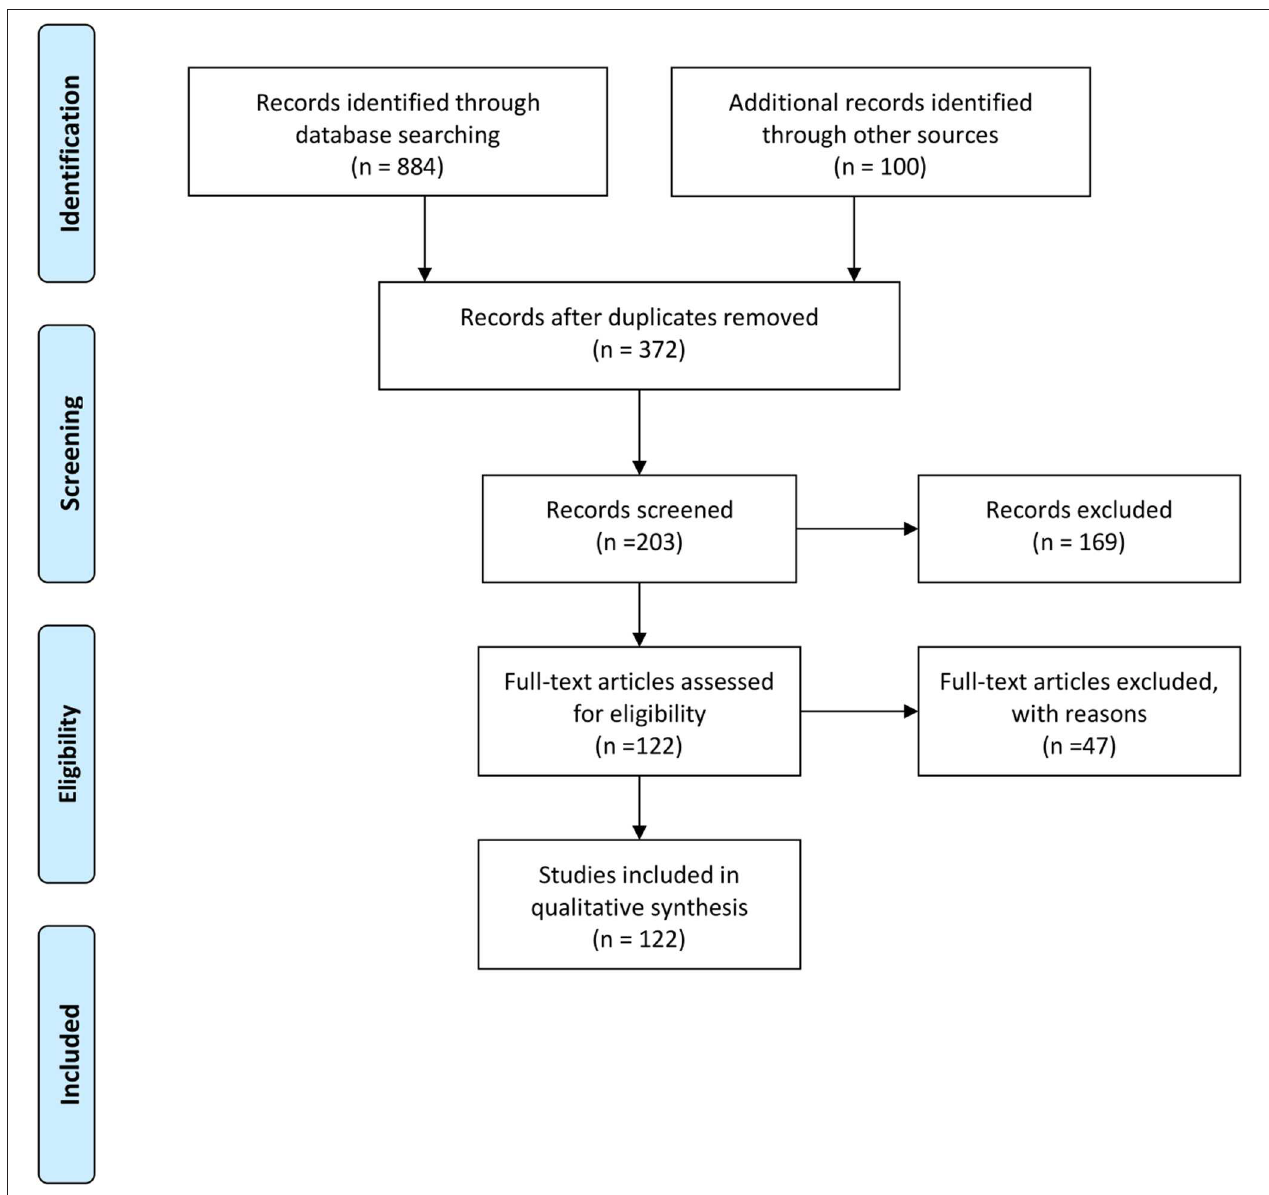
FIGURE 1 | PRISMA